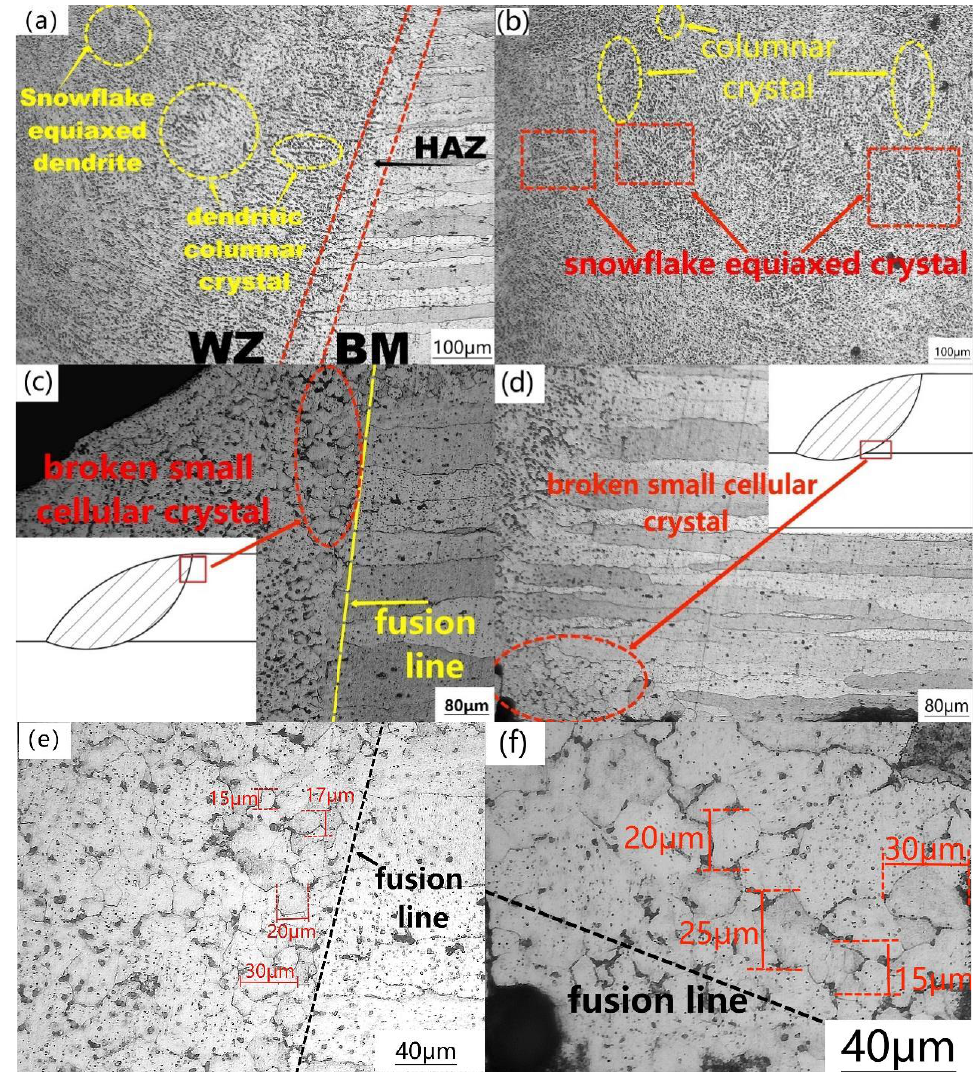
Figure 2. Microstructure of 6005 aluminum alloy MIG welded lap joint: ( a ) fusion line, ( b ) weld center, ( c ) broken grains in the upper right corner of the fusion line, ( d ) broken grains in the lower right corner of the fusion line, ( e ) enlarged view of the upper right corner, ( f ) enlarged view of the lower right corner.